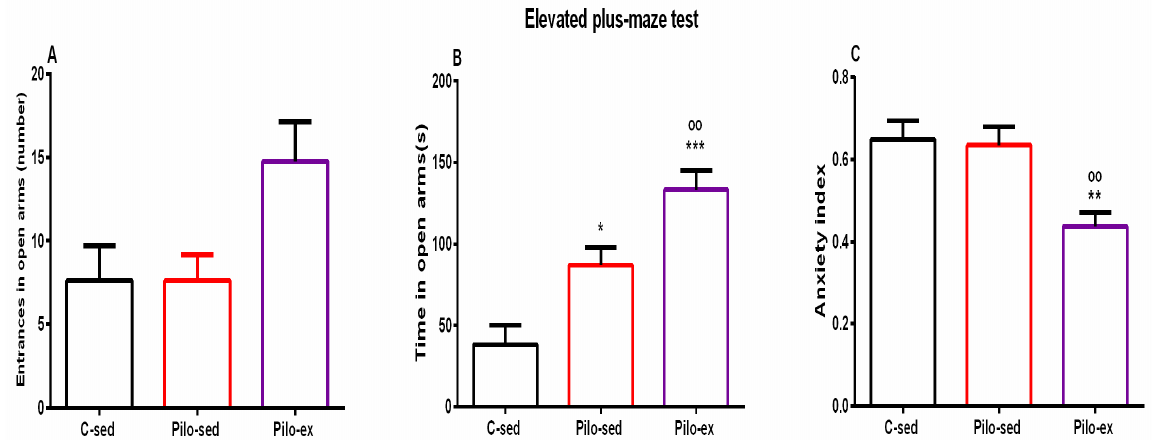
Figure 6. Effect of endurance training, applied before and after SE, on ( A ) number of entrances in open arms, ( B ) time (s) in open arms, * p = 0.017, *** p = 0.001, respectively, in comparison with the C-sed group, oo p = 0.024, in comparison with the Pilo-sed group, ( C ) ** p = 0.005 in comparison with the C-sed group, oo p = 0.009 in comparison with the Pilo-sed group. Analysis of variance demonstrated a significant main effect of exercise [F(2, 23) = 17.311, p < 0.01] on time spent in the open arms of the EPM. Both groups treated with Pilo had decreased levels of anxiety, and spent a longer time in the aversive area in comparison with the C-sed animals ( p = 0.017 and p = 0.001, respectively) (Figure 6B). Moreover, endurance training enhanced this impulsive-like behavior ( p = 0.024 compared to the Pilo-sed group) (Figure